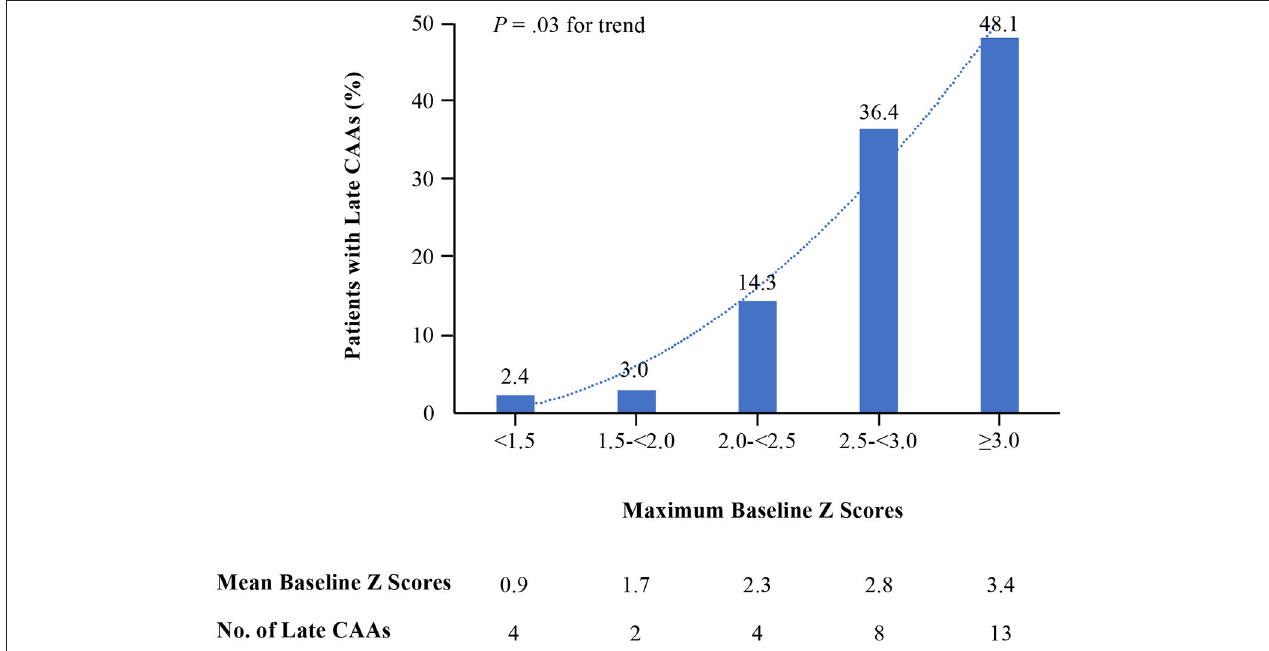
FIGURE 1 | Baseline maximum Z scores and rates of late coronary artery